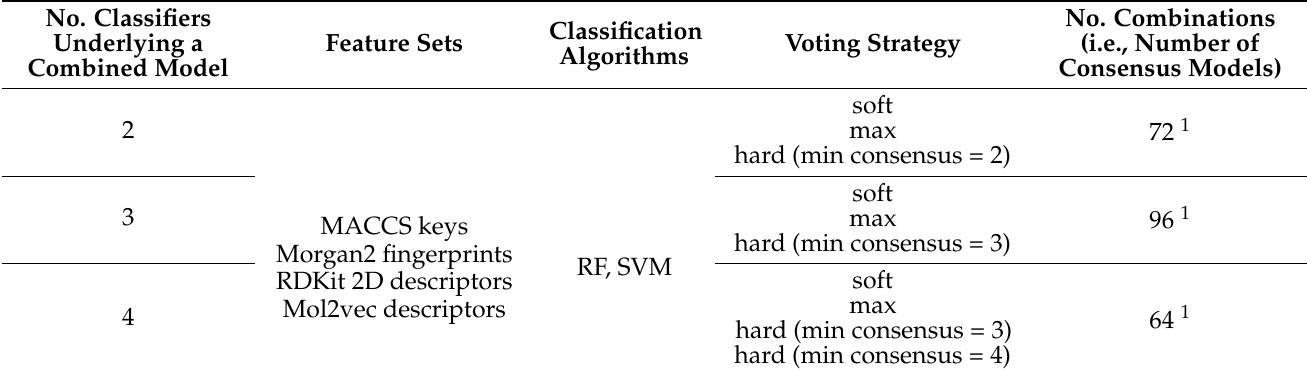
Table 3. Overview of the composition of the combined models.